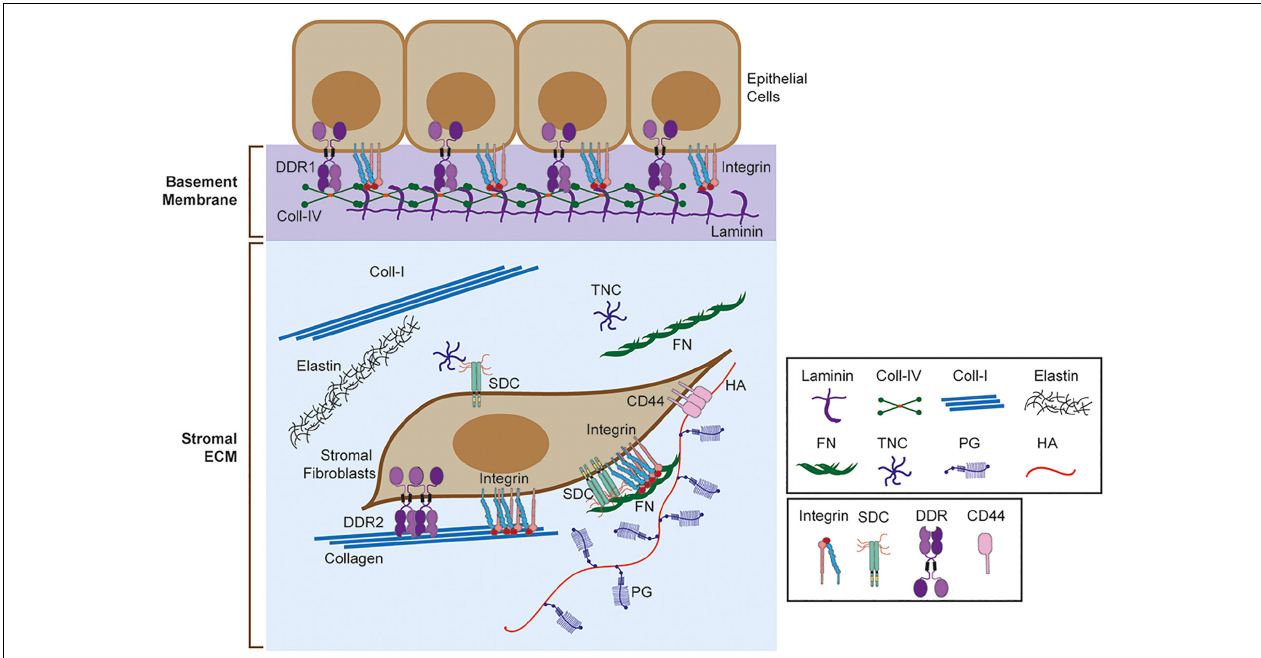
FIGURE 1 | Extracellular matrix (ECM) and ECM receptors. Schematic representation of basement membrane and stromal ECM and ECM receptors. Selected ECM molecules are shown here including laminin, collagen IV (Coll-IV), collagen I (Coll-I), elastin, fibronectin (FN), tenascin C (TNC), proteoglycan (PG), and hyaluronic acid (HA). ECM receptors, including integrin, sydecans (SDC), discoidin domain receptors (DDRs), and CD44 are also shown. Integrins bind different matrix, including collagen, laminin, and FN. SDC binds TNC and FN through heparan sulfate (HS) chains. DDR1 binds to fibrillar collagens (Coll-I, Coll-II, Coll-III) and Coll-IV, while DDR2 binds to fibrillar collagens only. CD44 binds to